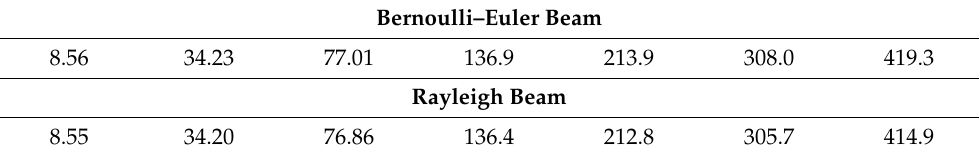
Table 1. Euler–Bernoulli and Rayleigh beam eigenfrequencies ( Hz ) for simply supported